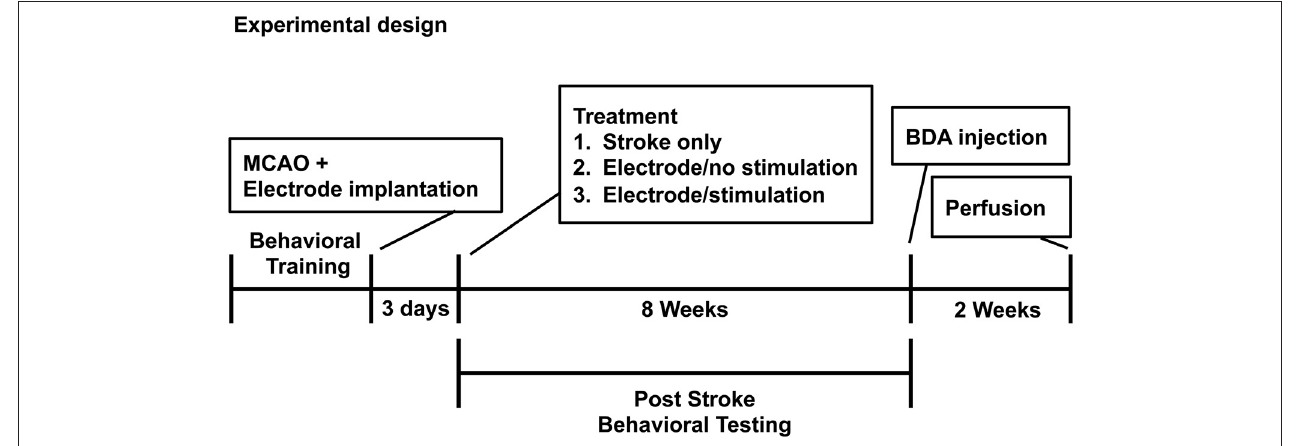
FIGURE 1 | Experimental design and timeline.